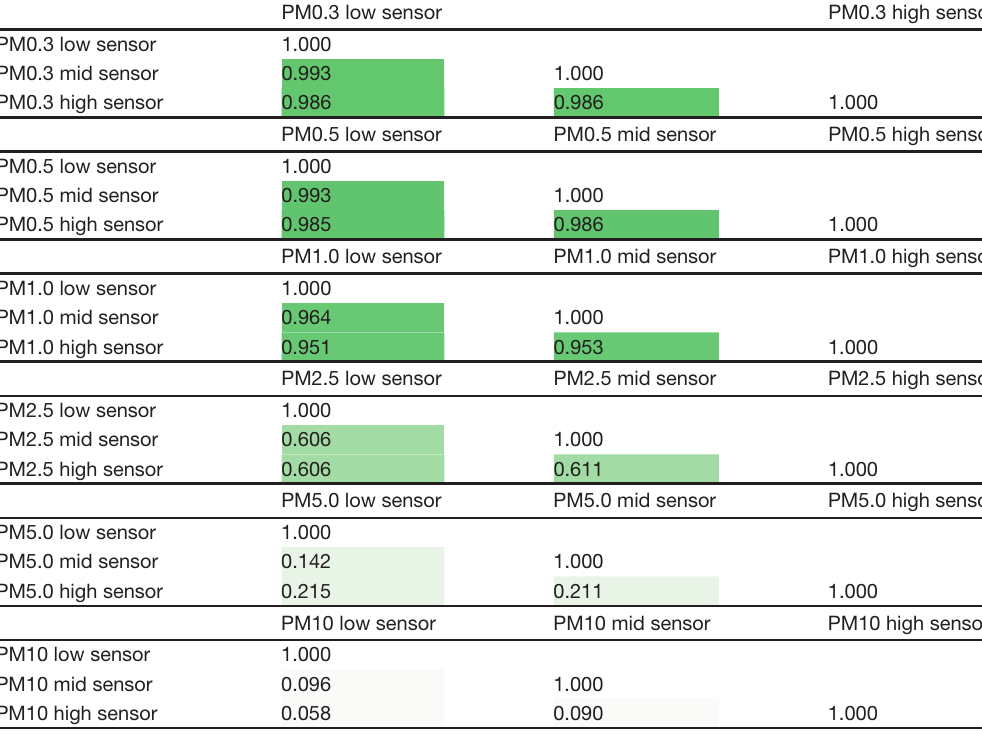
Minimum and maximum readings’ variations across the three series of testing for 1 min and 15 min blowing, respectively. (Source: Authors,